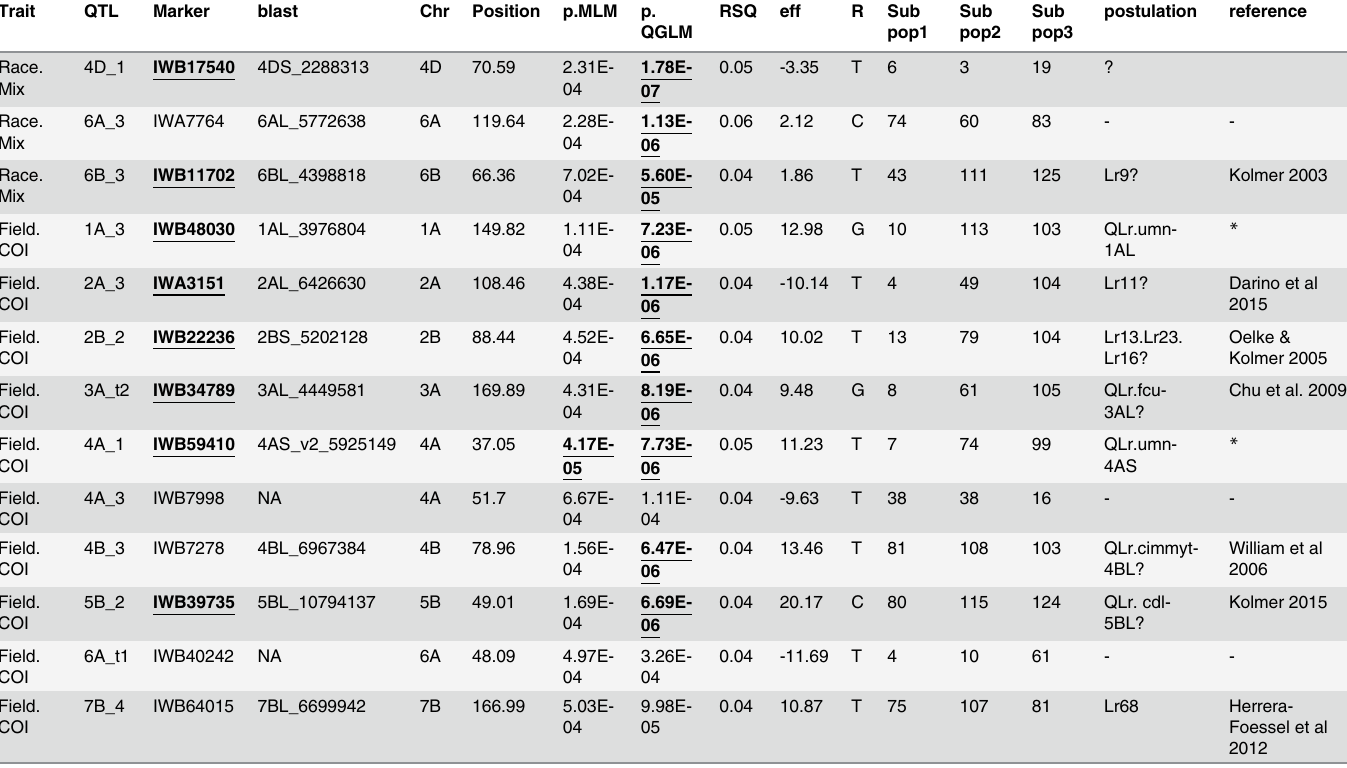
1A_3 ( QLr . umn-1AL ) was mapped to position 149.8 cM on chromosome 1AL for both field BLUE and seedling race mixture traits (Table 3). Chromosome 1AL is not associated with adult leaf rust resistance [41]. It is also not likely to be Lr59 [52] because Lr59 is located on an alien introgression that is unlikely to be present in this AM panel. QTL 4A_1 ( QLr . umn-4AS ), highly associated with field resistance (both p.MLM and p.QGLM surpassing the simpleM threshold), was represented by two SNP markers (IWB13323 and IWB59410), located at 37 cM of 4AS (Fig 5 and Table 2). No known QTLs or genes are present on chromosome 4AS that confer resistance to leaf